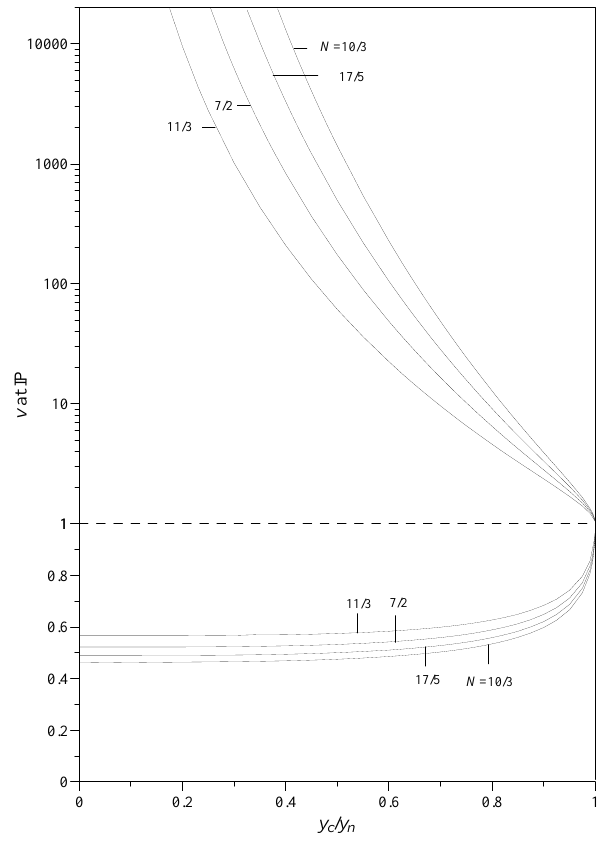
Fig. 3. Plot of eight solution curves representing the two values of v at the inflection points (IP), one on each of the M1 and M3 profiles, against the various values of y c / y n (0 <y c / y n 1) under four N